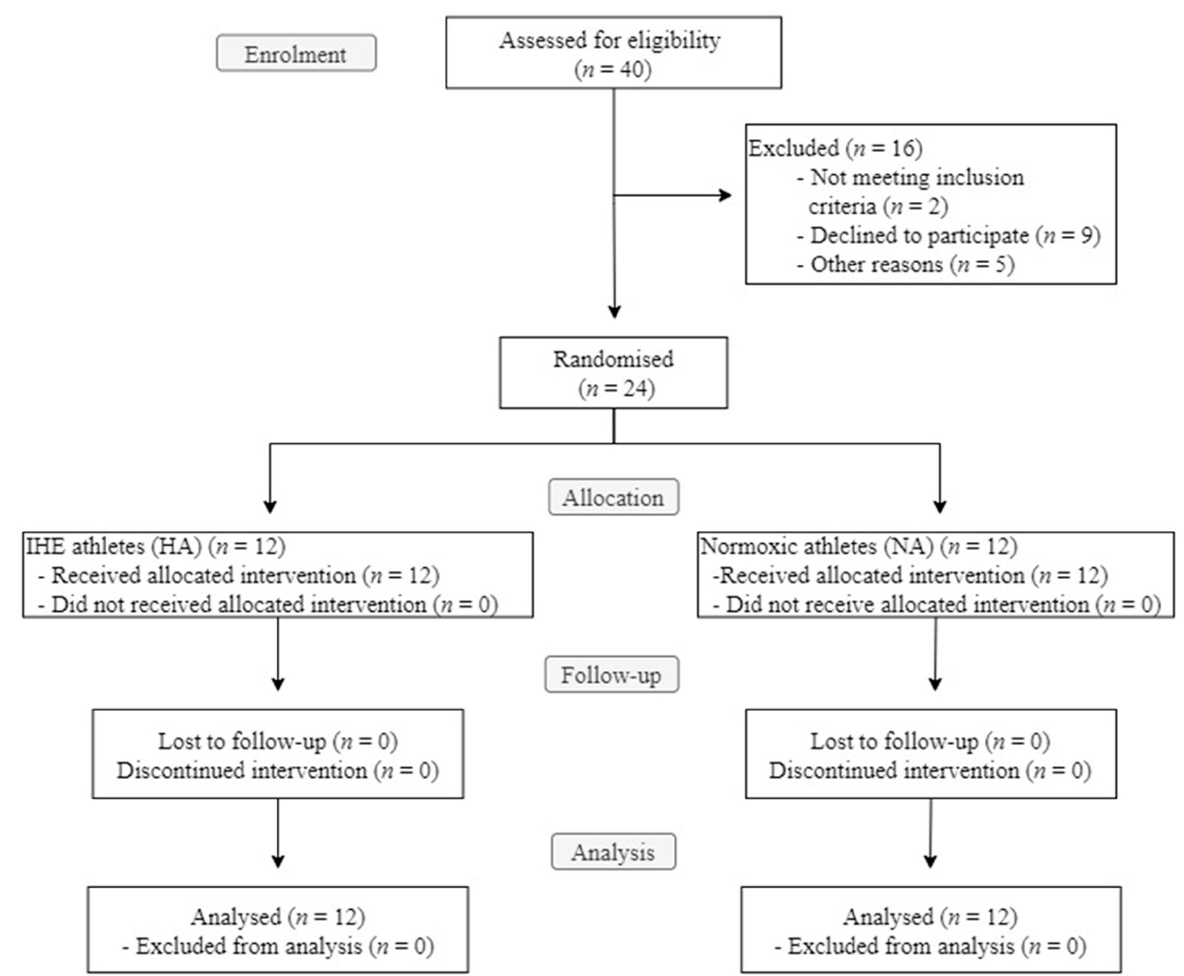
Figure 2. A flow chart of the enrolment and randomization process, according to the CONSORT regulations.